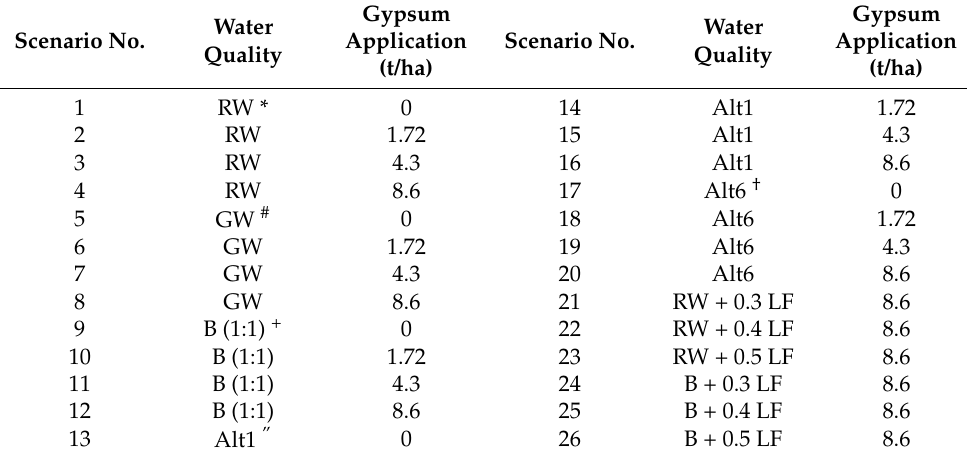
Table 1. Different water quality and gypsum application scenarios performed for the calcareous soil (Cal) under wine grapes.